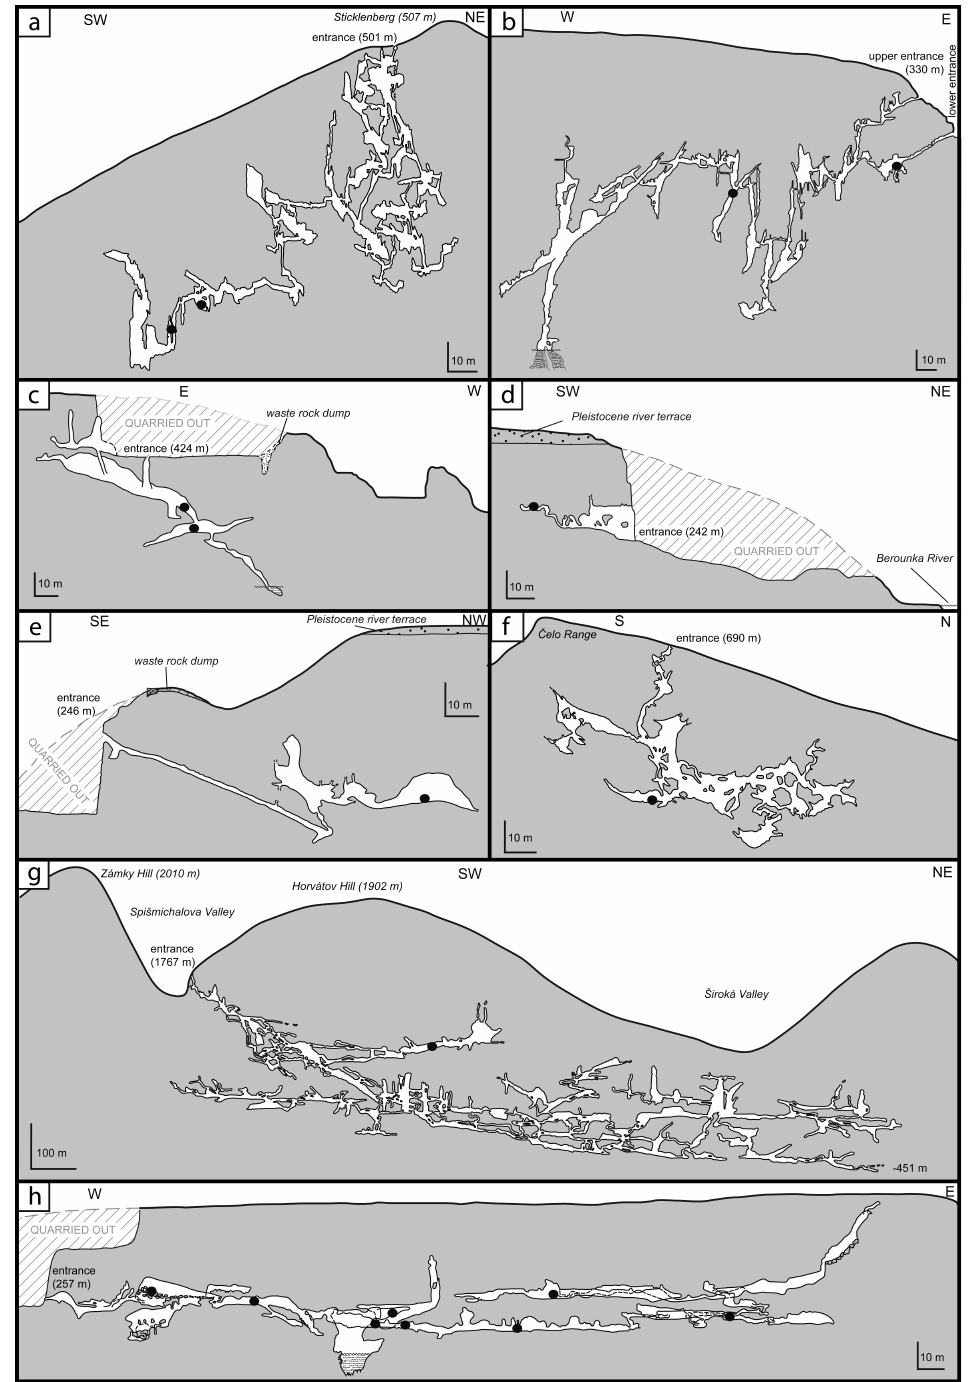
Fig. 3. Cave sections (projected profiles) of selected studied caves. Coarsely crystalline CCC locations are indicated by black dots. (a) Apos- telh¨ohle, Germany: mapping by M. Erlenmeyer and co-workers, section after Richter et al. (2010b); (b) Na Javorce Cave, Czech Republic: modified and redrawn after Dragoun et al. (2011), mapping by J. Dragoun, J. Vejlupek and J. Novotn ´ y; (c) Malachitdom Cave, Germany: mapping and section after Erlenmeyer and Schudelski (1992); (d) Port´alov´a Cave, Czech Republic: original drawing, mapping by J. ˇZivor and co-workers; (e) BUML Cave, Czech Republic: original drawing, mapping by S. Mart´ınek and P. Zbuzek; (f) Haˇcova Cave, Slovakia: original drawing by B. ˇSm´ıda, mapping by B. ˇSm´ıda, M. Haˇco and co-workers; (g) Mesaˇcn´y Tieˇn Cave, Slovakia: original drawing by B. ˇSm´ıda, mapping by B. ˇSm´ıda, I. Pap and co-workers; (h) Jama Chelosiowa–Jaskinia Jaworznica Cave System, Poland: mapping and section drawing by J. Gubała and A. Kasza, see also Urban and Rzonca